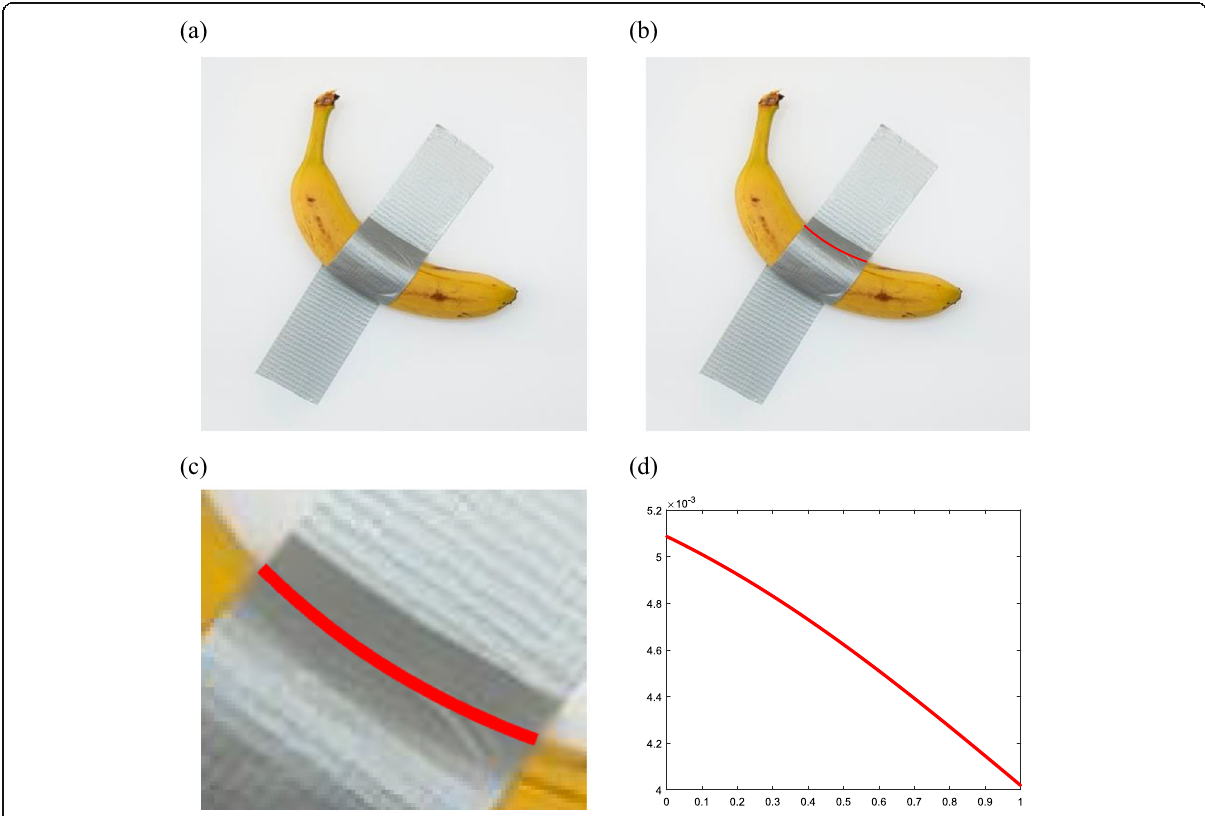
Fig. 12 Banana border completion. a : Partially occluded banana; b : Typical curve; c : Local zoomed-in view; d : Curvature